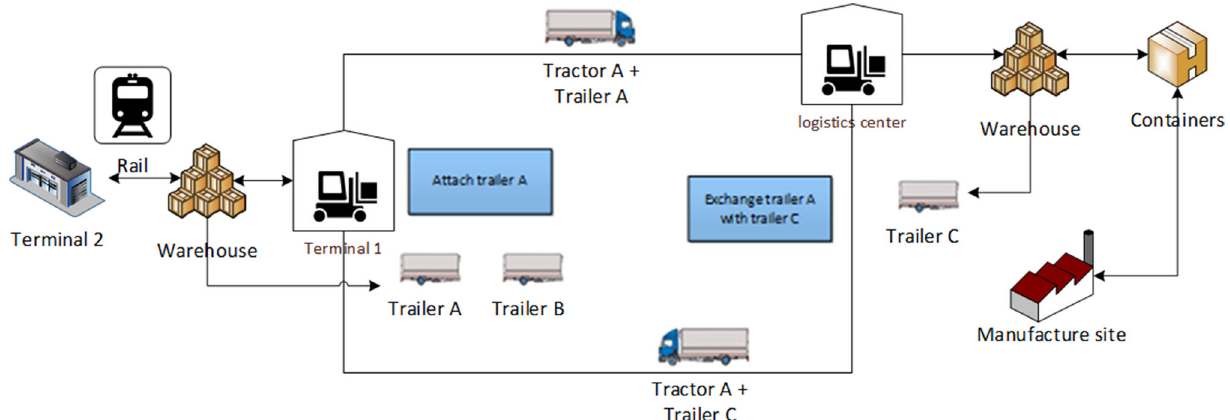
Fig. 1 Containerisation